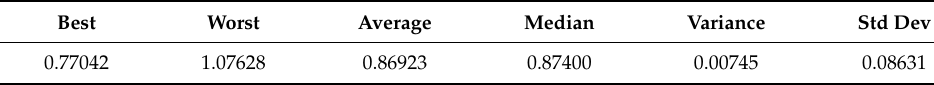
Table 4. Statistics of the performance of ImHS for the case study.